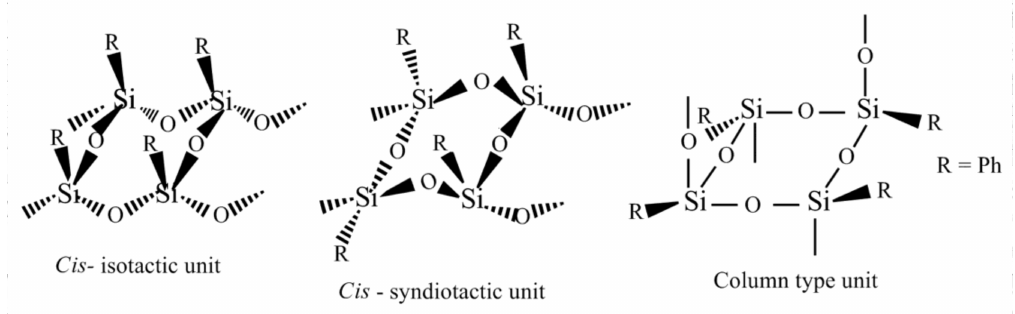
Figure 1. Structures of units in cyclolinear ladder polyphenylsilsesquioxanes (CL